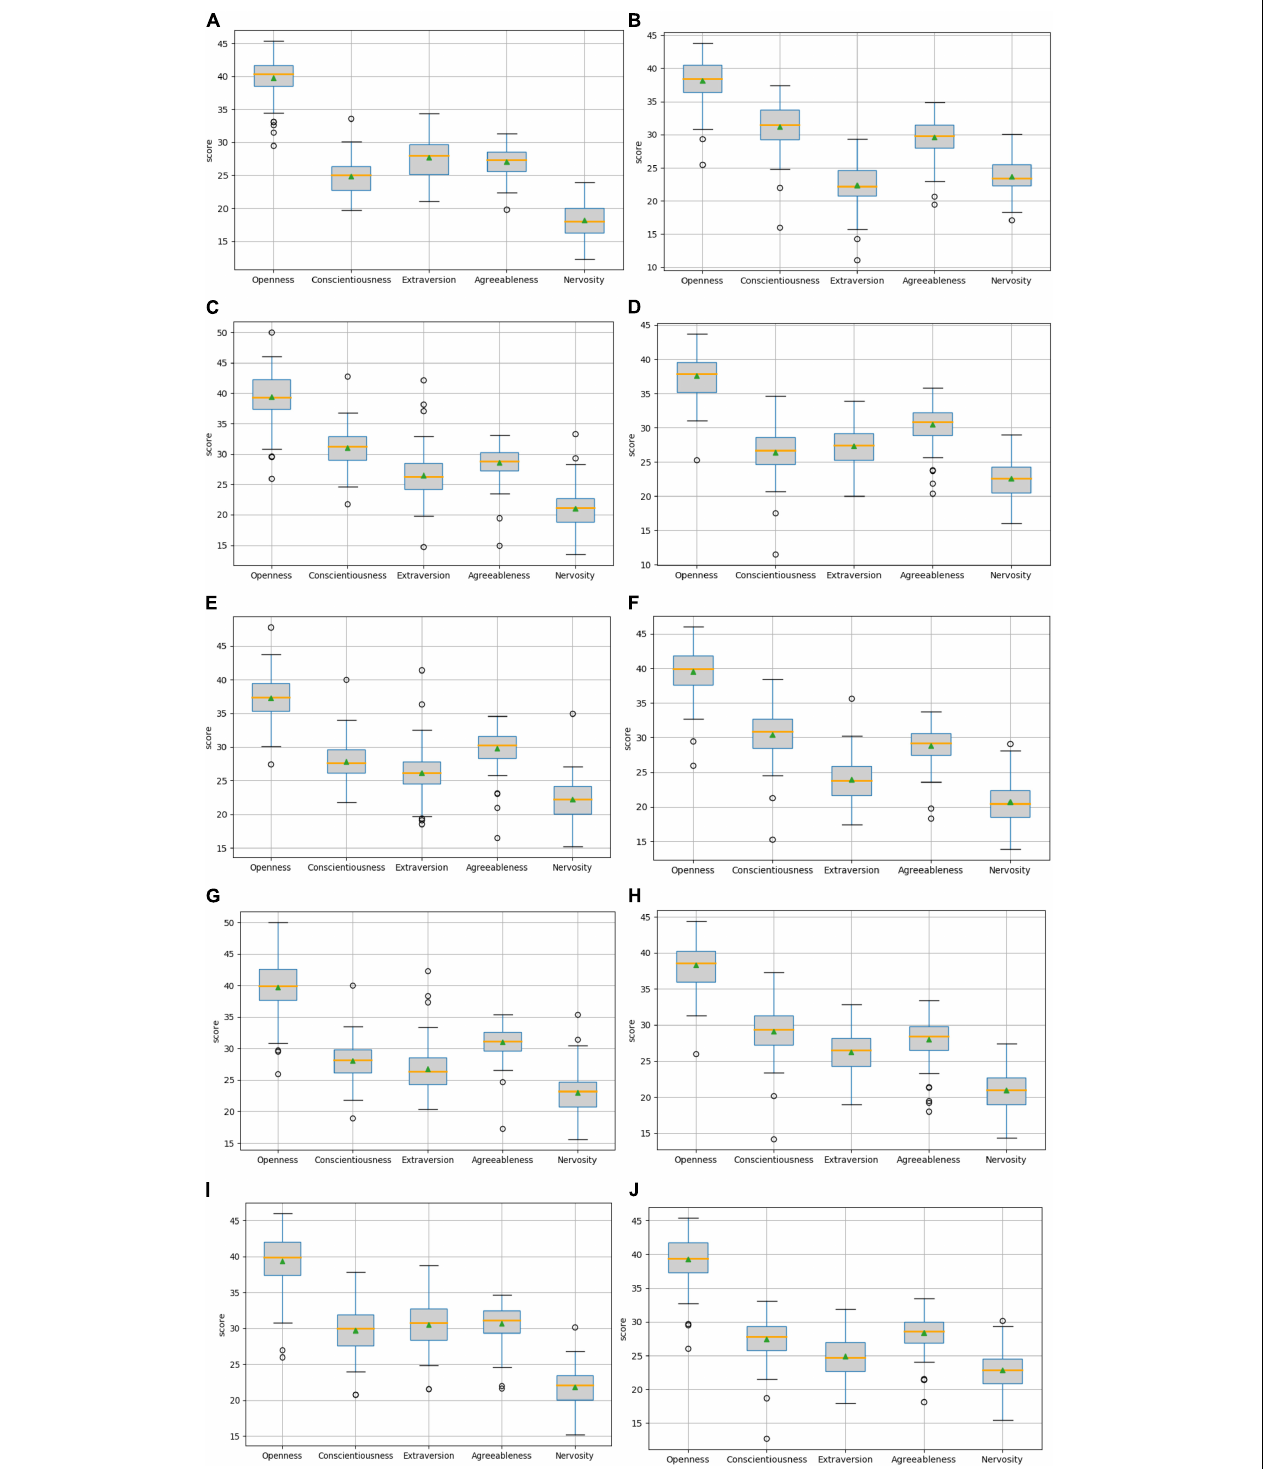
FIGURE 8 | The personality distribution of follow users for each type is shown below: (A) The personality distribution of follow of users with high openness; (B) The personality distribution of follow of users with low openness; (C) The personality distribution of follow of users with high conscientiousness; (D) The personality distribution of follow of users with low conscientiousness; (E) The personality distribution of follow of users with high extraversion; (F) The personality distribution of follow of users with low extraversion; (G) The personality distribution of follow of users with high agreeableness; (H) The personality distribution of follow of users with low agreeableness; (I) The personality distribution of follow of users with high neuroticism; (J) The personality distribution of follow of users with low neuroticism.